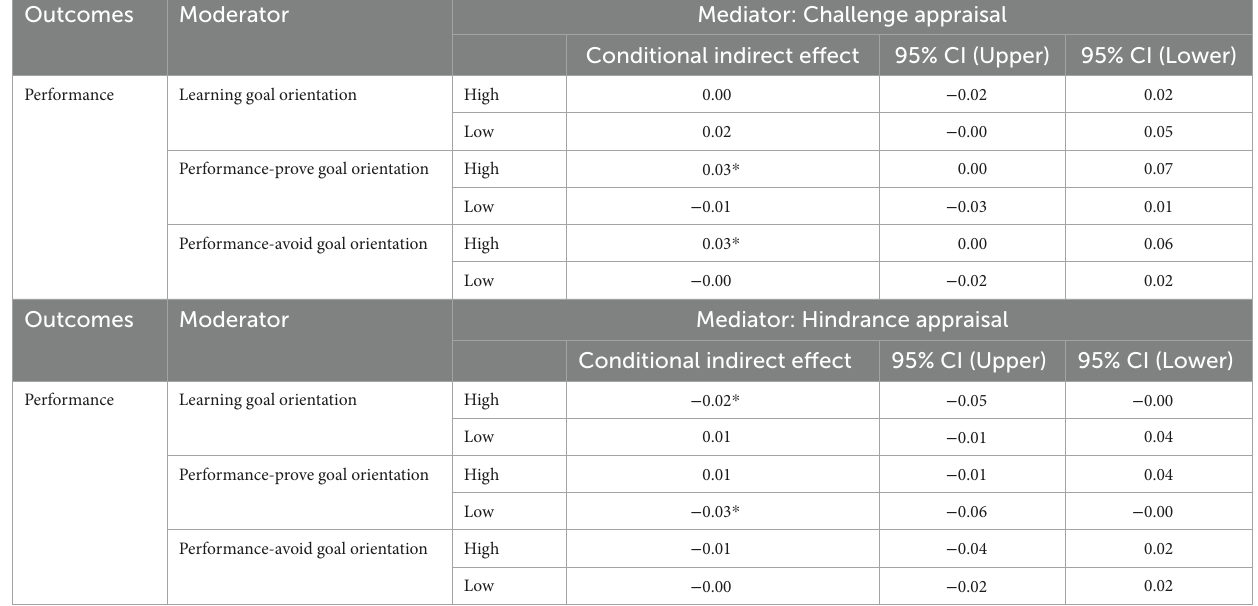
TABLE 3 Mediated moderation results for laissez-faire leadership across levels of learning goal orientation and performance goal orientation.